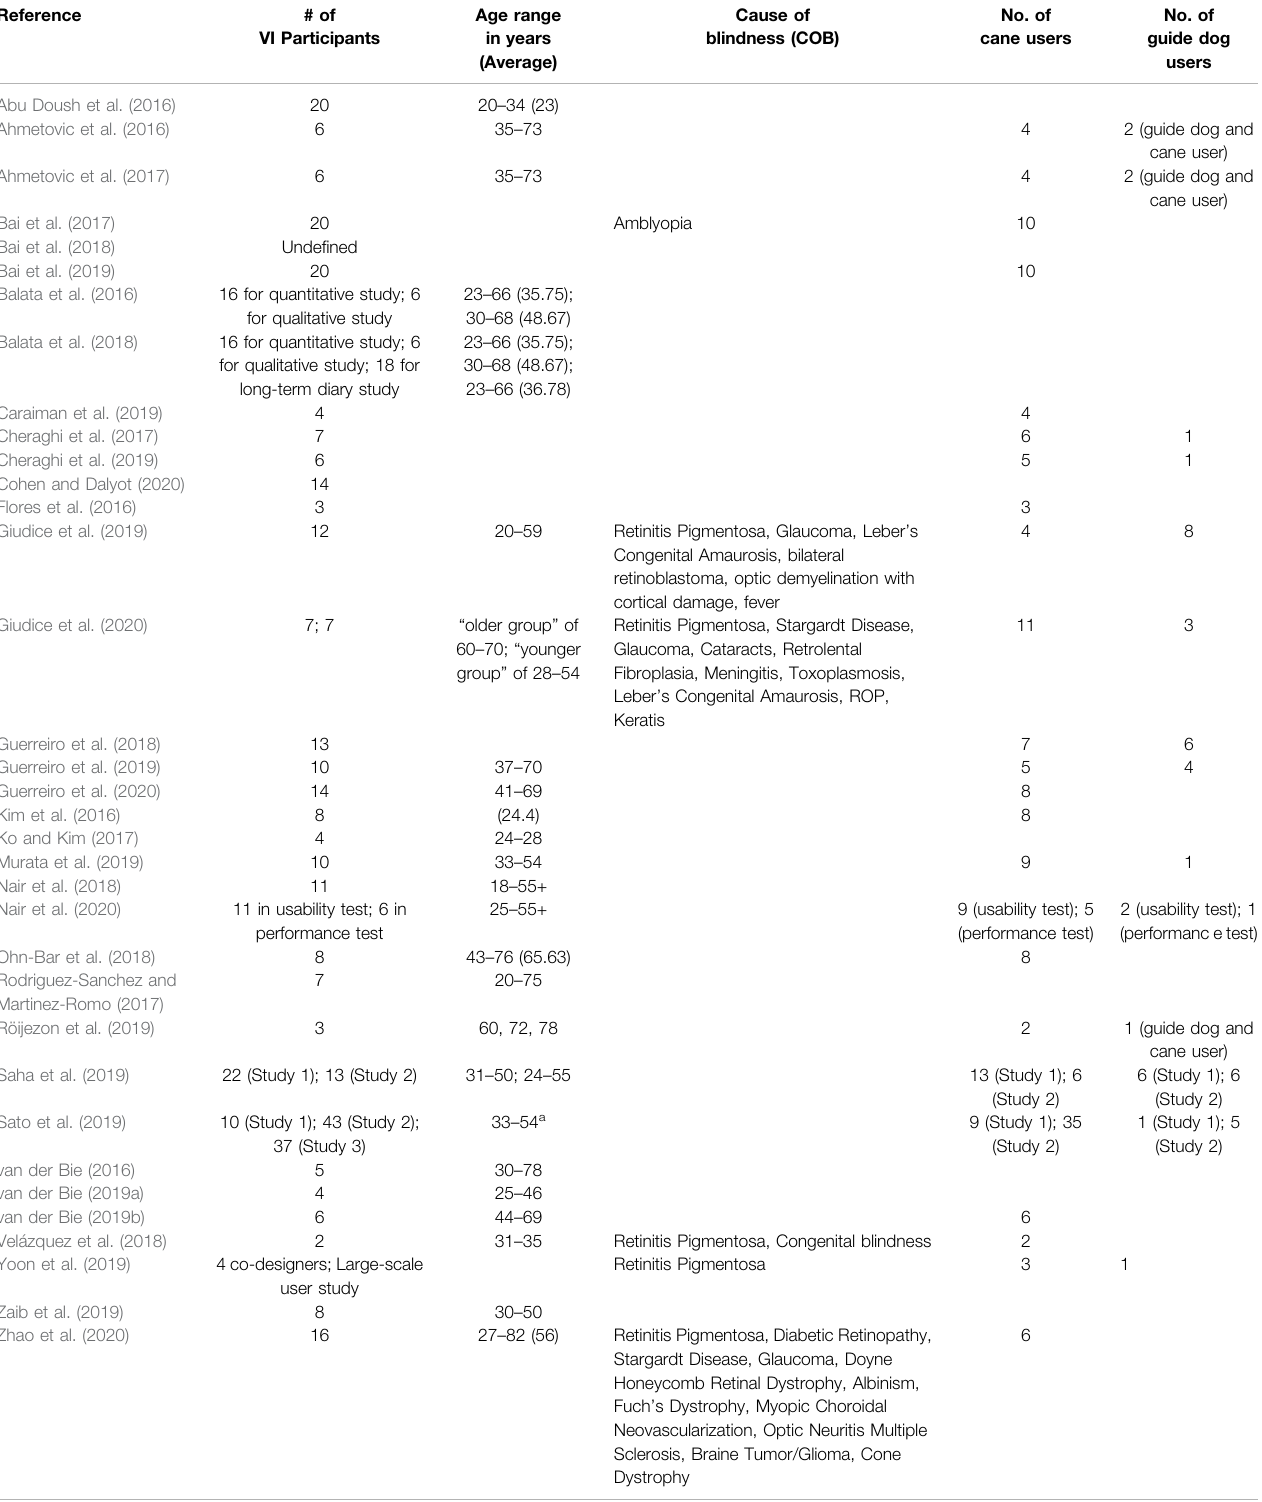
TABLE 2 | Participants with visual impairments who executed